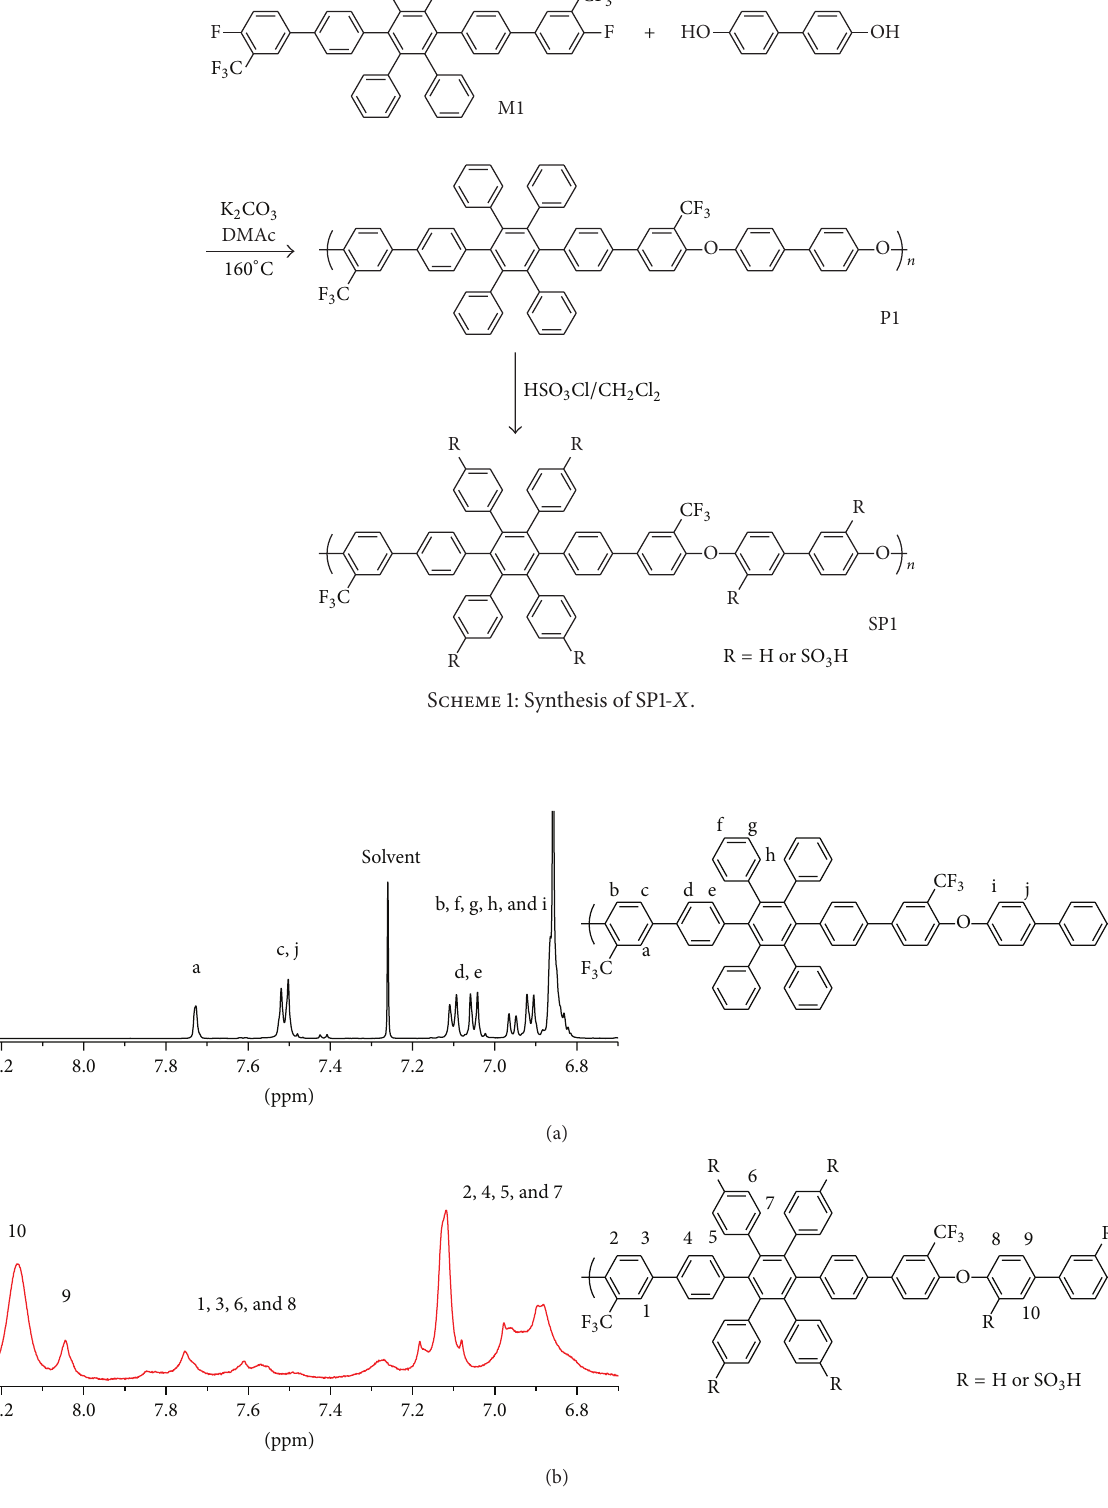
Figure 1: 1 H NMR spectrum of polymer P1 (a) and after sulfonation SP1- 𝑋